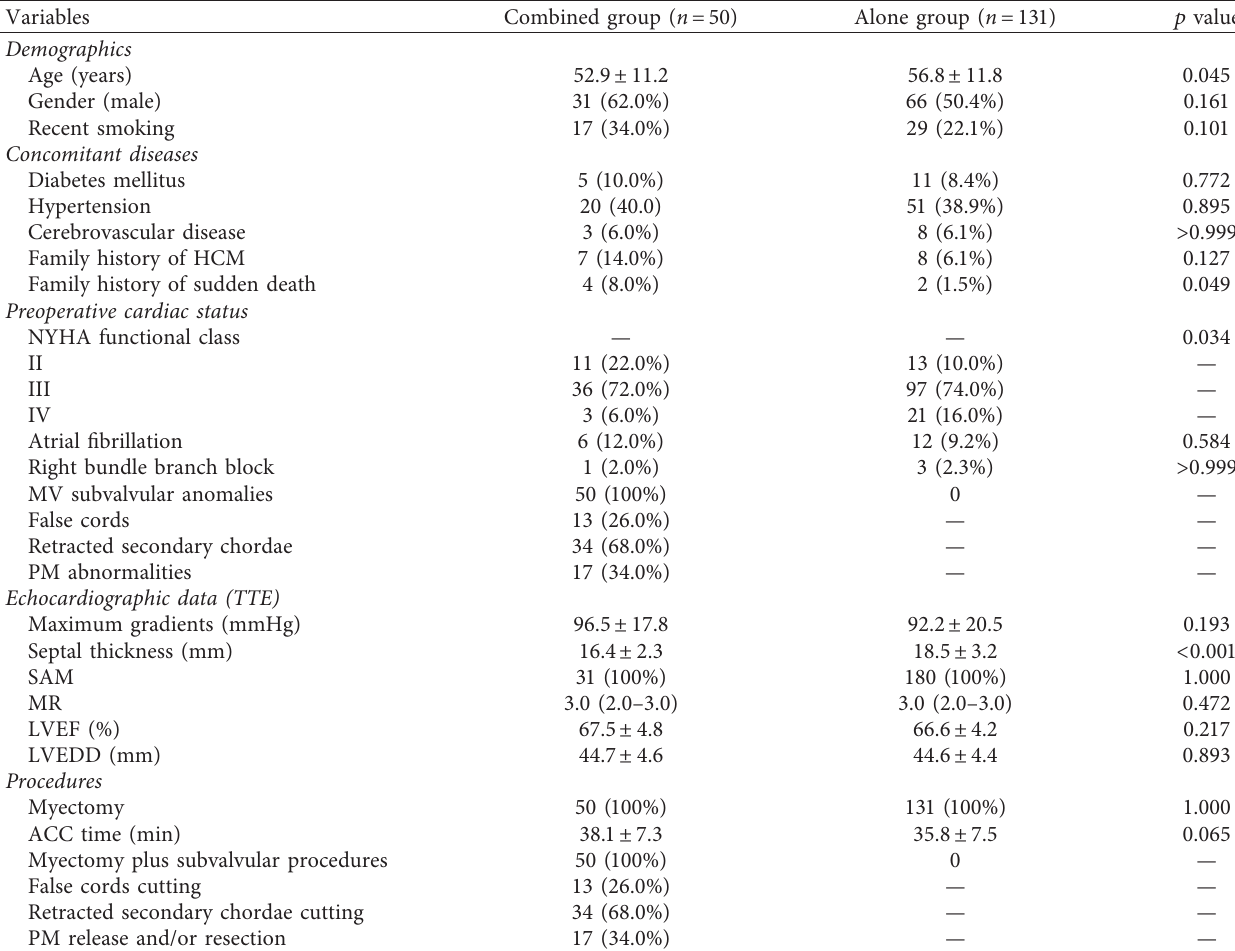
Table 1: Baseline and surgical